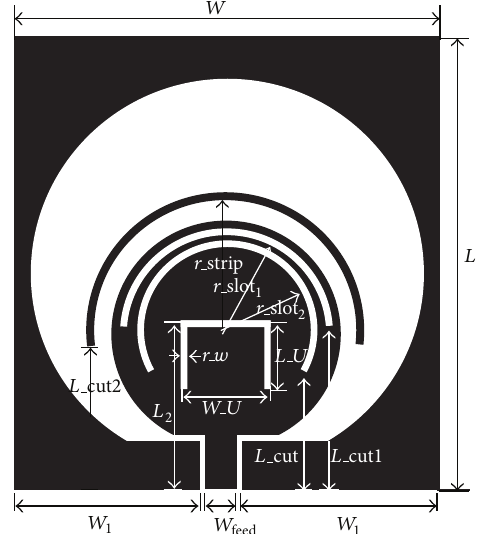
Figure 3: Schematics of the proposed quadruple band-notched UWB antenna.